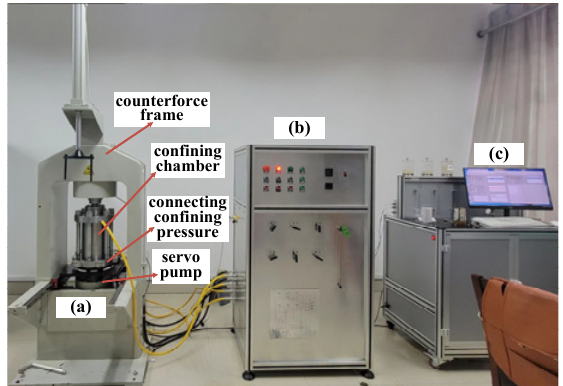
Figure 1. Experimental system: ( a ) principal pressure testing machine; ( b ) hydraulic power supply; ( c ) software control system.